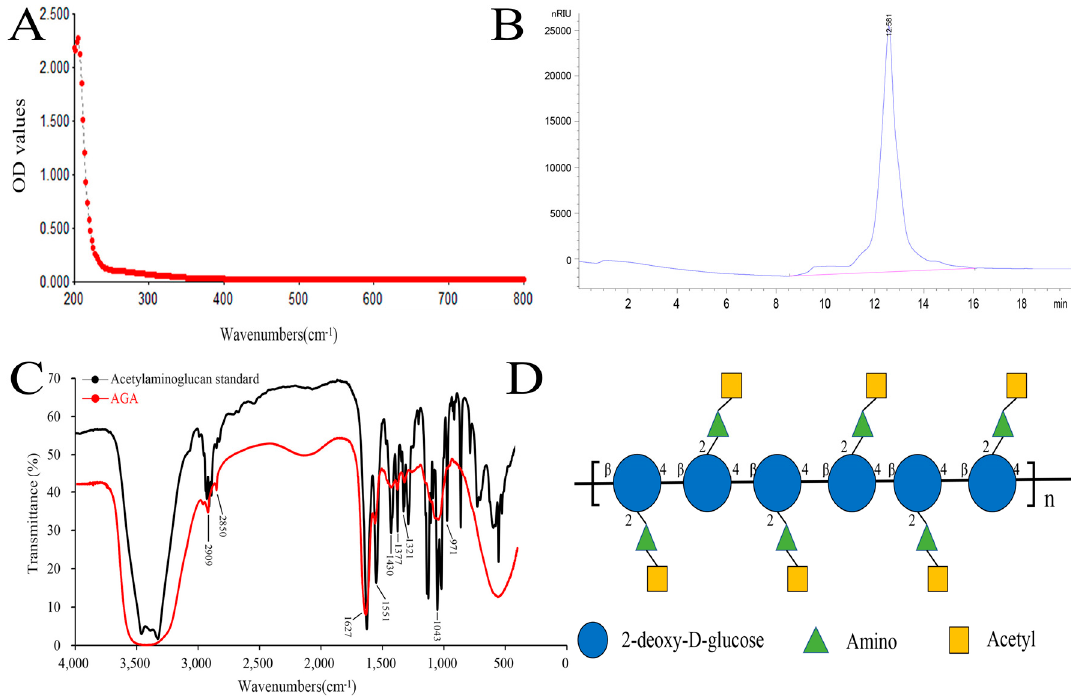
Figure 1. UV spectrum ( A ), HPLC ( B ), FT-IR ( C ) and structure formula ( D ) of AGA. Figure 1C showed the FT-IR scan results of acetylaminoglucan standard and